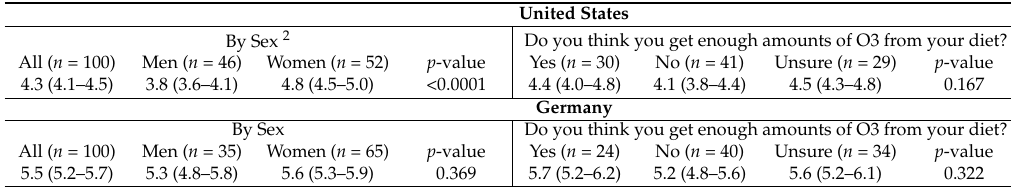
Table 2. Mean (95%CL) Omega-3 Index by sex and perception of dietary adequacy among adults in the United States and Germany ( n = 200; ages 18–80 years) 1